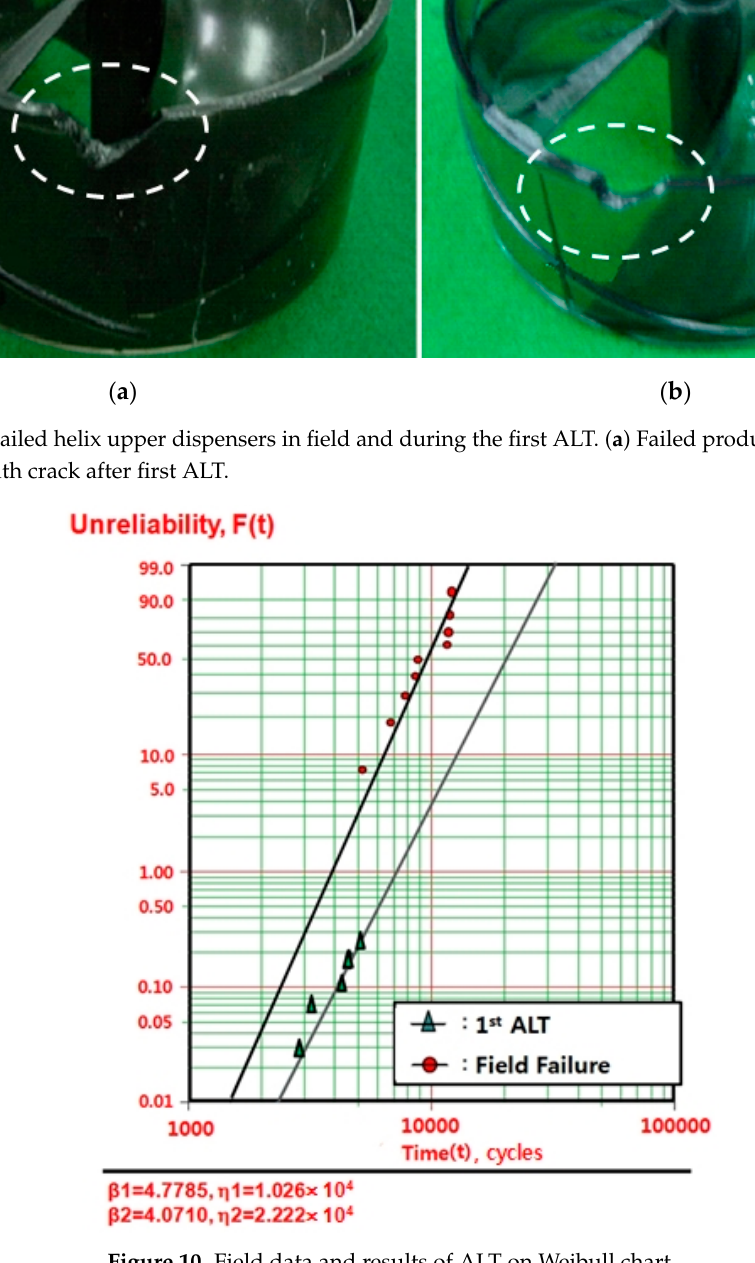
Figure 10. Field data and results of ALT on Weibull chart.